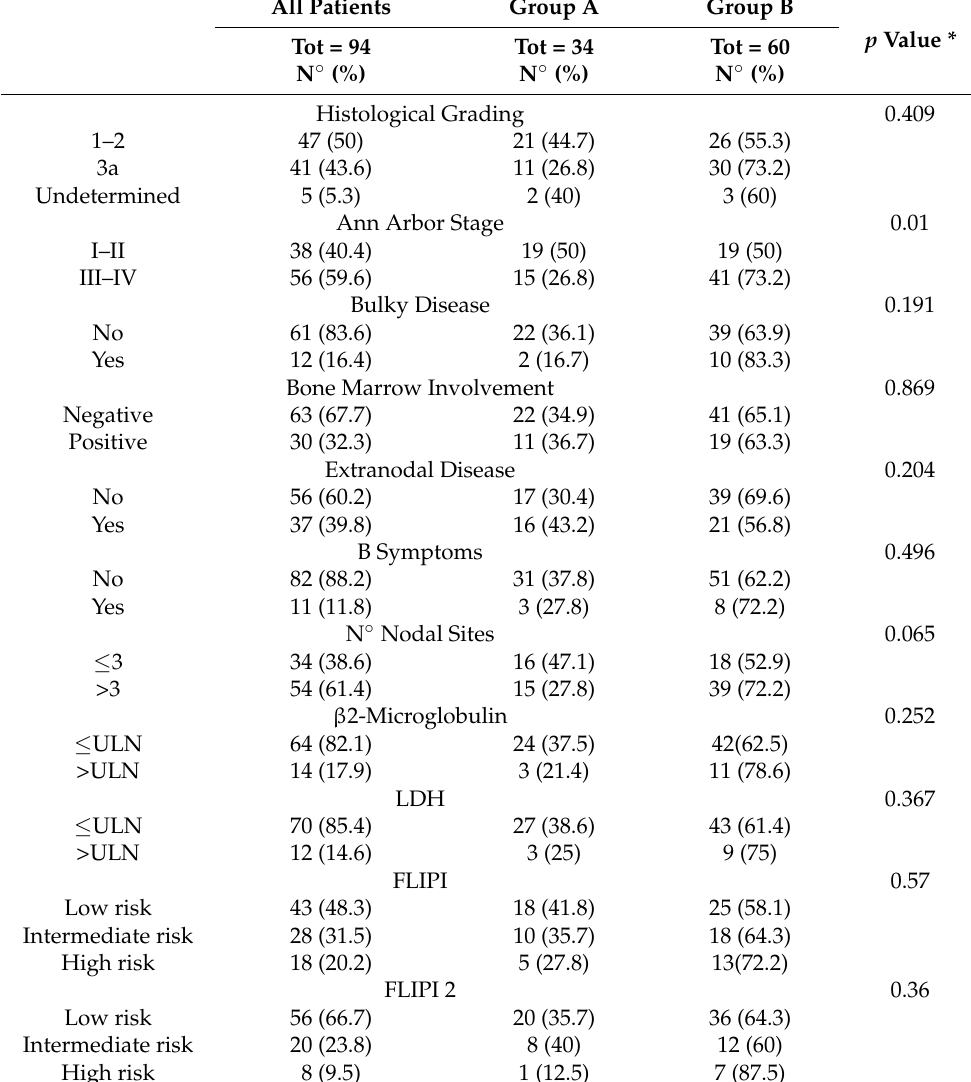
Table 1. The baseline patient characteristics for the studied population, stratified according to the pretreatment Maximum Standardized Uptake Value (SUV max ) with the cut-off at